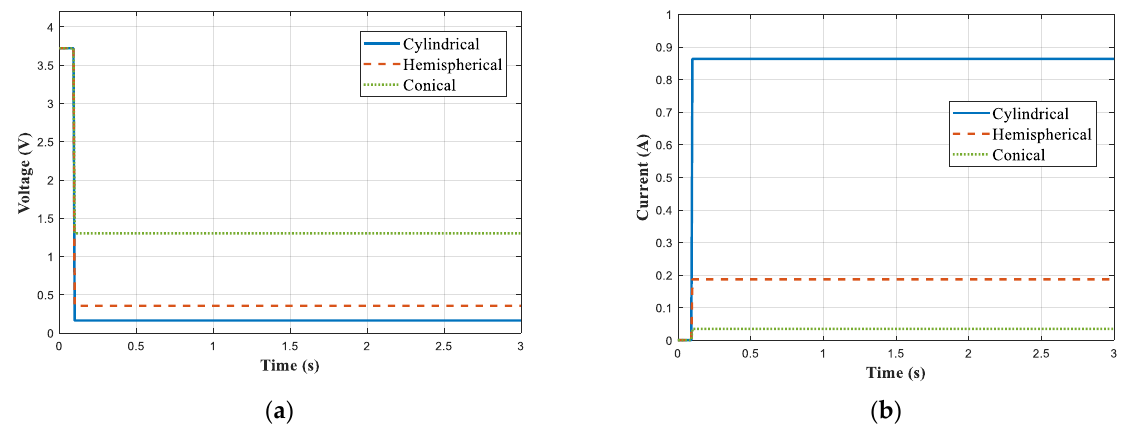
Figure 7. Comparison of electrical response for various indenters: ( a ) voltage; ( b ) current. Table 3. Electrical response of a LIB cell under various indenters.